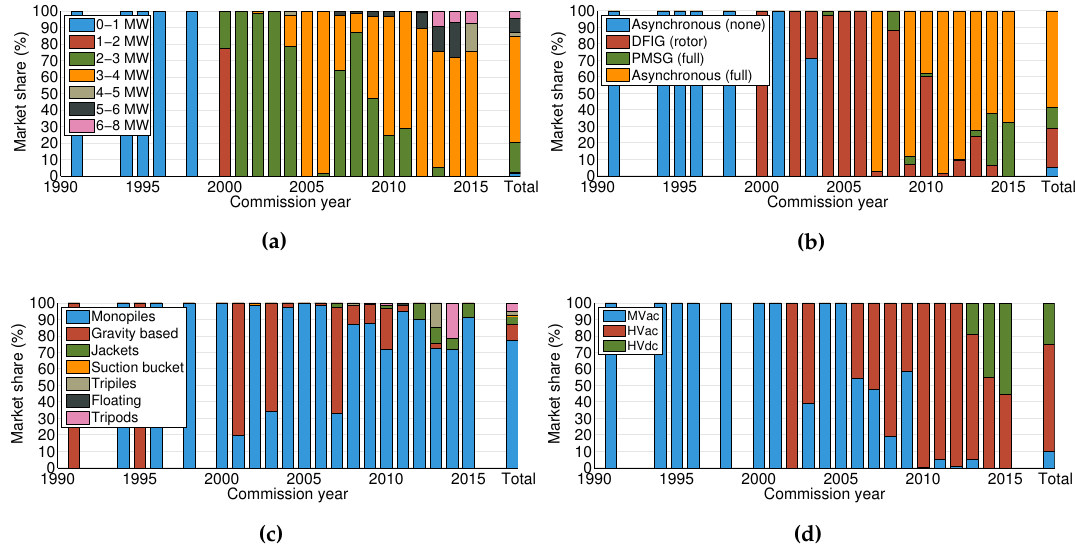
Figure 8. Early and total statistics for commissioned and under construction European OWFs [10,11,54]; ( a ) Turbine rated power; ( b ) Turbine electrical configuration; ( c ) Turbine support structure; ( d ) Transmission